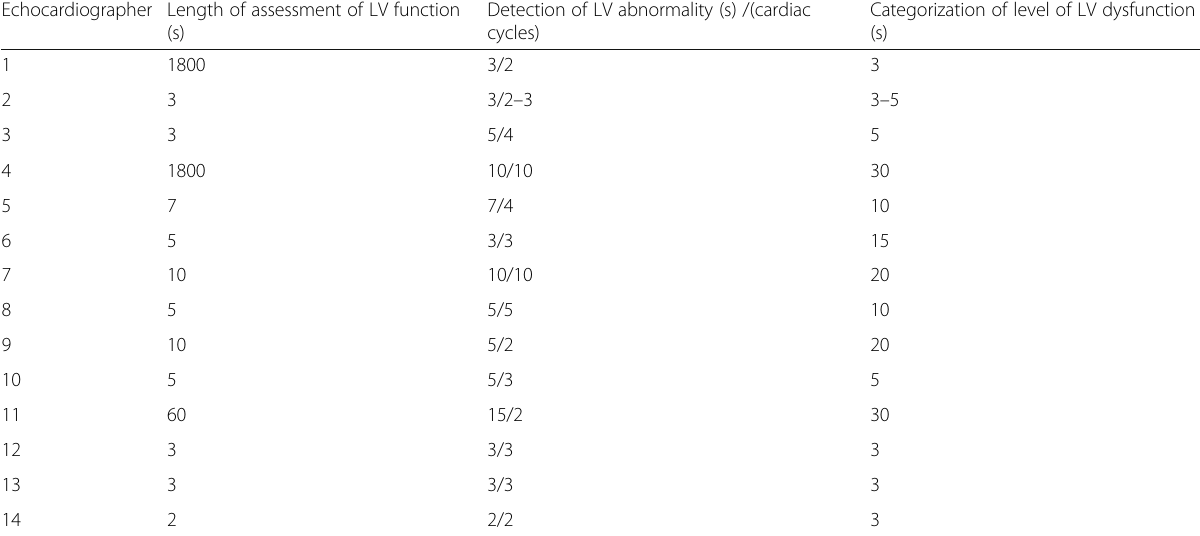
Table 7 Subjective clinical assessment of left ventricular (LV) systolic function reported by 14 echocardiographers Echocardiographer Length of assessment of LV function (s)